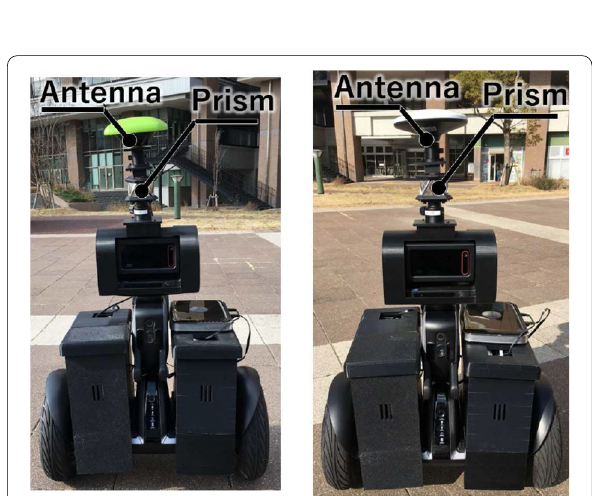
Fig. 11 Setup of the GNSS antenna and prism for the comparing experiment. The left-hand side describes the configuration for the QZSS, and the right-hand side describes the configuration for the